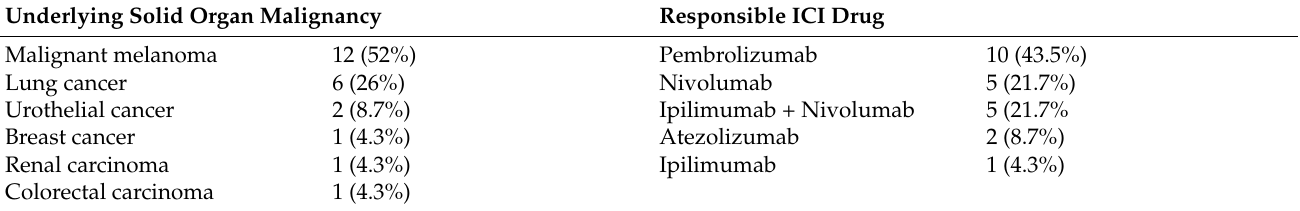
Table 1. Underlying oncologic disease and ICI treatment received by the admitted patients due to irAE needing hospital